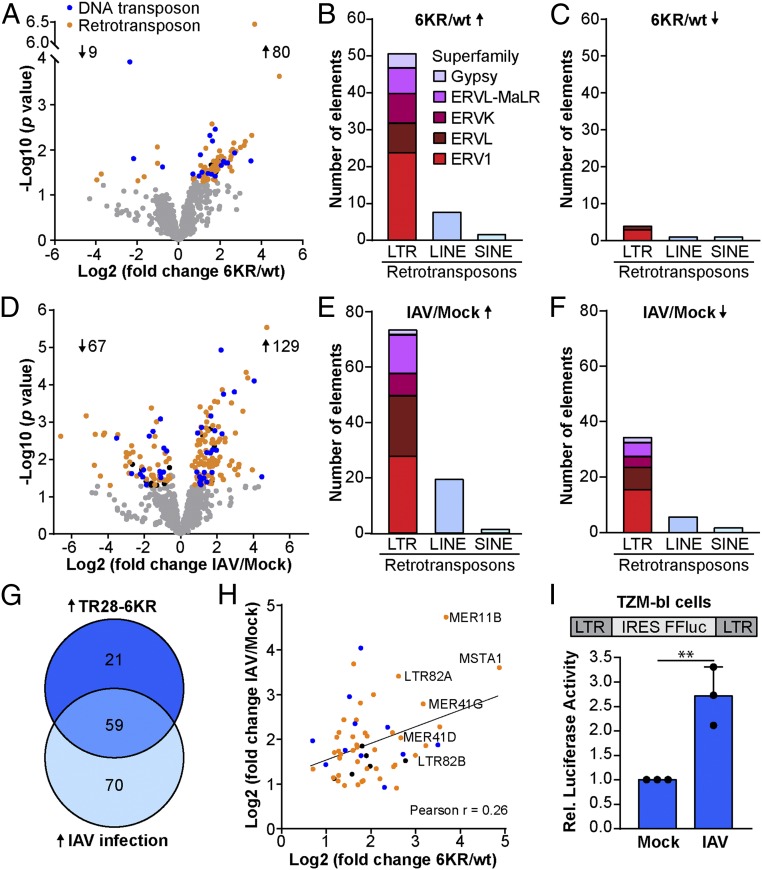
Up-regulation of transposable elements in cells expressing SUMOylation-deficient TRIM28 and during IAV infection. (A and D) Transcriptome datasets from Fig. 4 were reanalyzed for expression of repetitive elements comparing TRIM28-KO A549 cells reconstituted with wt TRIM28 versus TRIM28-6KR (A), or mock versus IAV-infected TRIM28-wt A549 cells (D). Elements with a P value < 0.05 and fold change >1.5 or <−1.5 are depicted in blue (DNA transposons), orange (retrotransposons), or black (others). (B, C, E, and F) Subclasses of retrotransposons that were significantly up- or down-regulated in TRIM28-6KR–expressing cells (B and C) or during IAV infection (E and F): LINE, long interspersed nuclear element; LTR, long-terminal repeat retrotransposon; SINE, short interspersed nuclear element. (G) Overlap analysis of TEs that are significantly up-regulated in TRIM28-6KR–expressing cells (TR28-6KR) and during IAV infection. (H) Fold-change correlation between the 59 TEs that are up-regulated in TRIM28-6KR cells and during IAV infection. Elements are depicted in blue (DNA transposons), orange (retrotransposons), or black (others). (I) TZM-bl cells that express Firefly luciferase under control of an LTR were infected with IAV (MOI = 50 PFU per cell) or mock infected. Firefly luciferase was measured at 16 hpi. Bars represent mean values and SDs of 3 independent experiments (each dot represents 1 replicate). Significance was determined by unpaired t test (**P < 0.01). See also Dataset S7.